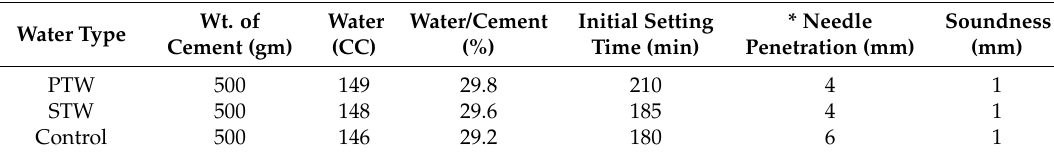
Table 5. Fresh properties of cement paste.